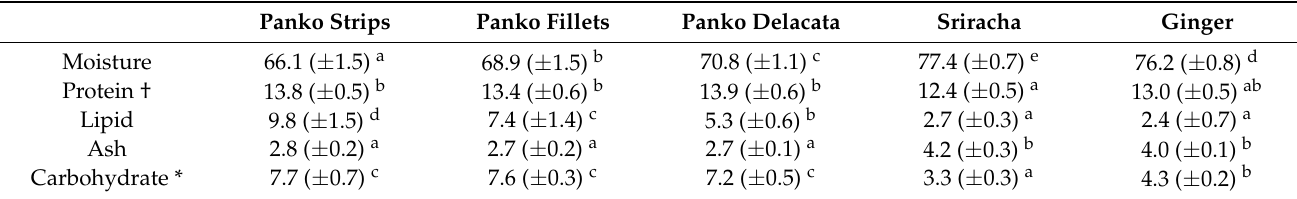
Table 1. Proximate compositions (wet weight